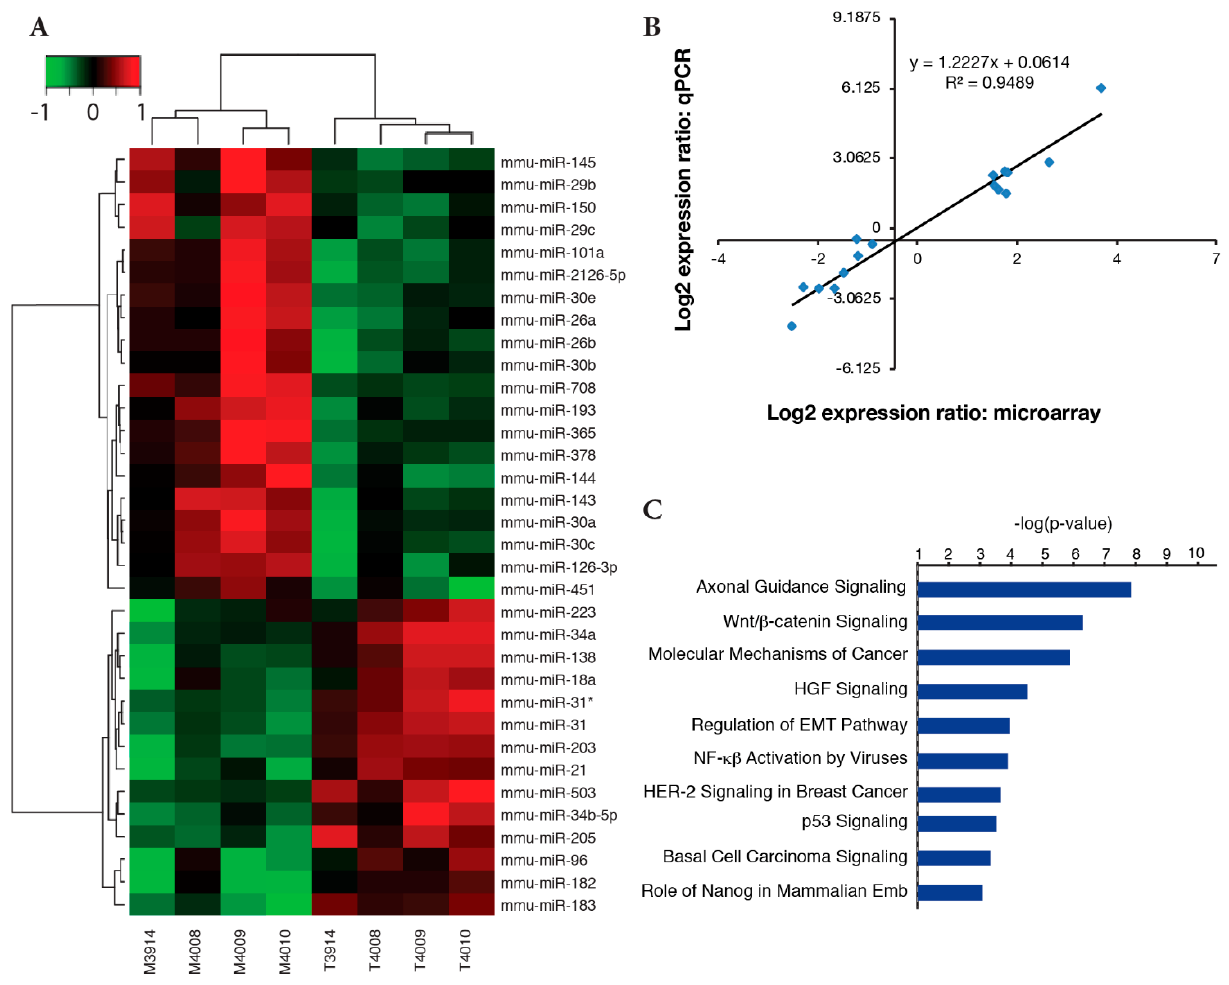
Figure 4. Identification and validation of differentially expressed miRNA genes. ( A ) Heatmap of 34 significantly differentially expressed miRNA genes between four pairs of matched tumors (T) and their adjacent mammary tissues (M) from ATF3-expressing mammary glands. ( B ) Correlation of gene expression between miRNA genes identified by a microarray and selected for validation with RT-qPCR assays using RNA from a total of six tumors and six paired, normal, mammary gland controls, including the four pairs used for the microarray experiments. ( C ) IPA analysis of the integrated mRNA and miRNA datasets.